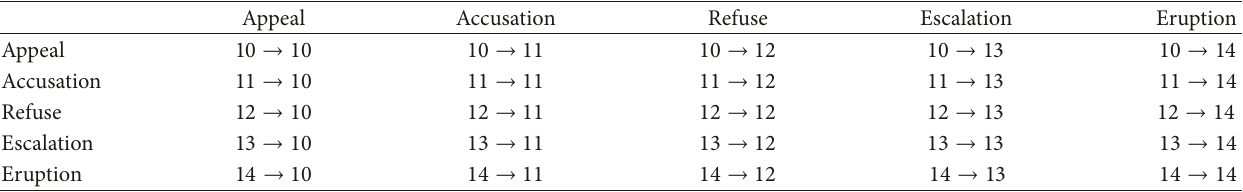
Table 3: State transition matrix (25